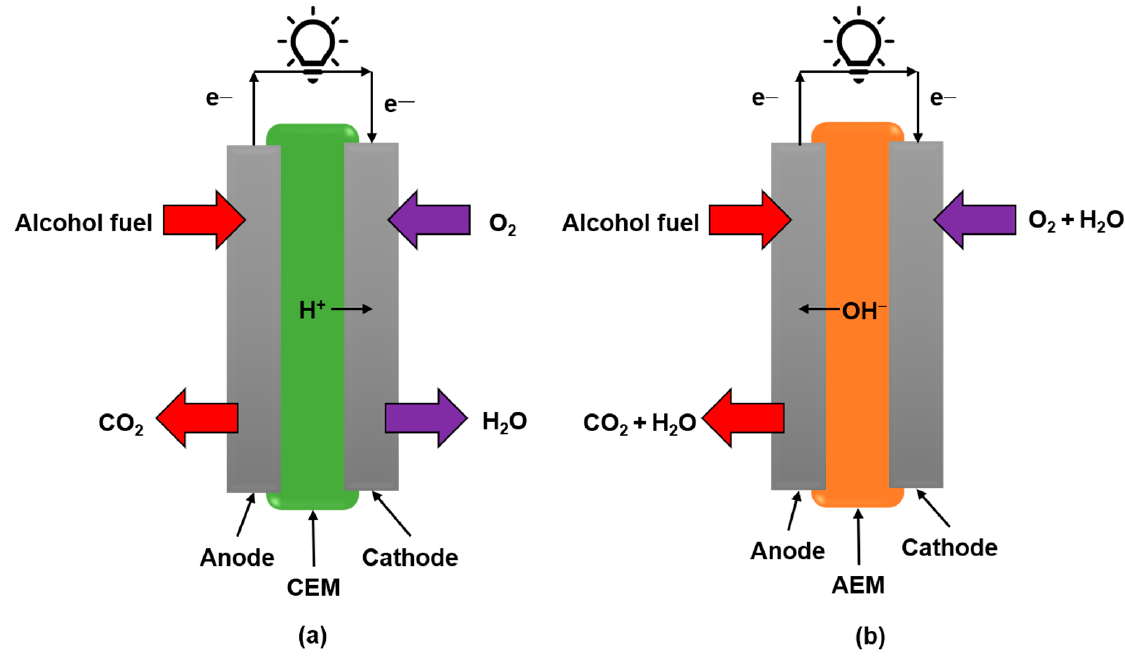
Figure 1. Alcohol fuel cells using ( a ) CEM and ( b ) AEM.